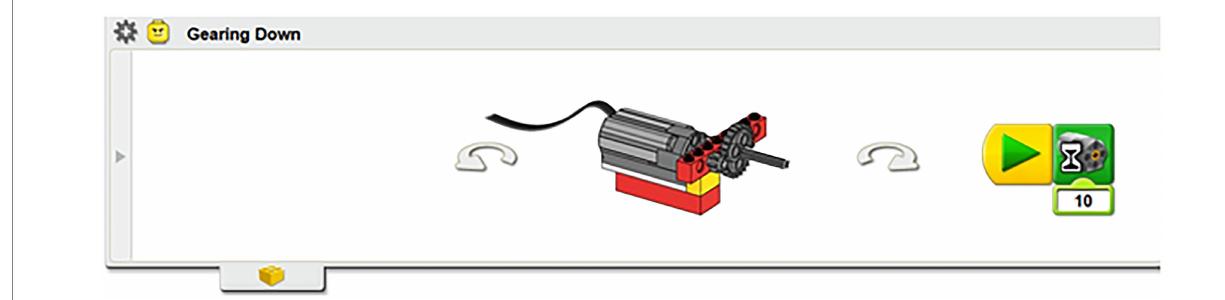
FIGURE 1 Instructions on WeDo computer program to learn about gearing down.